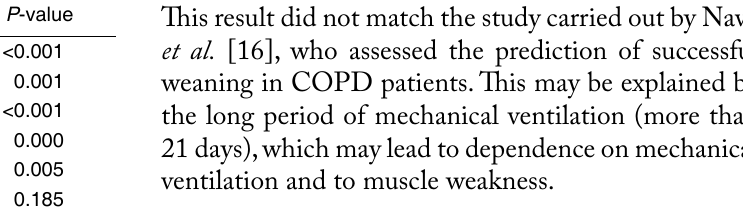
Table 8 Relationship between diaphragmatic displacement and other parameters Variables